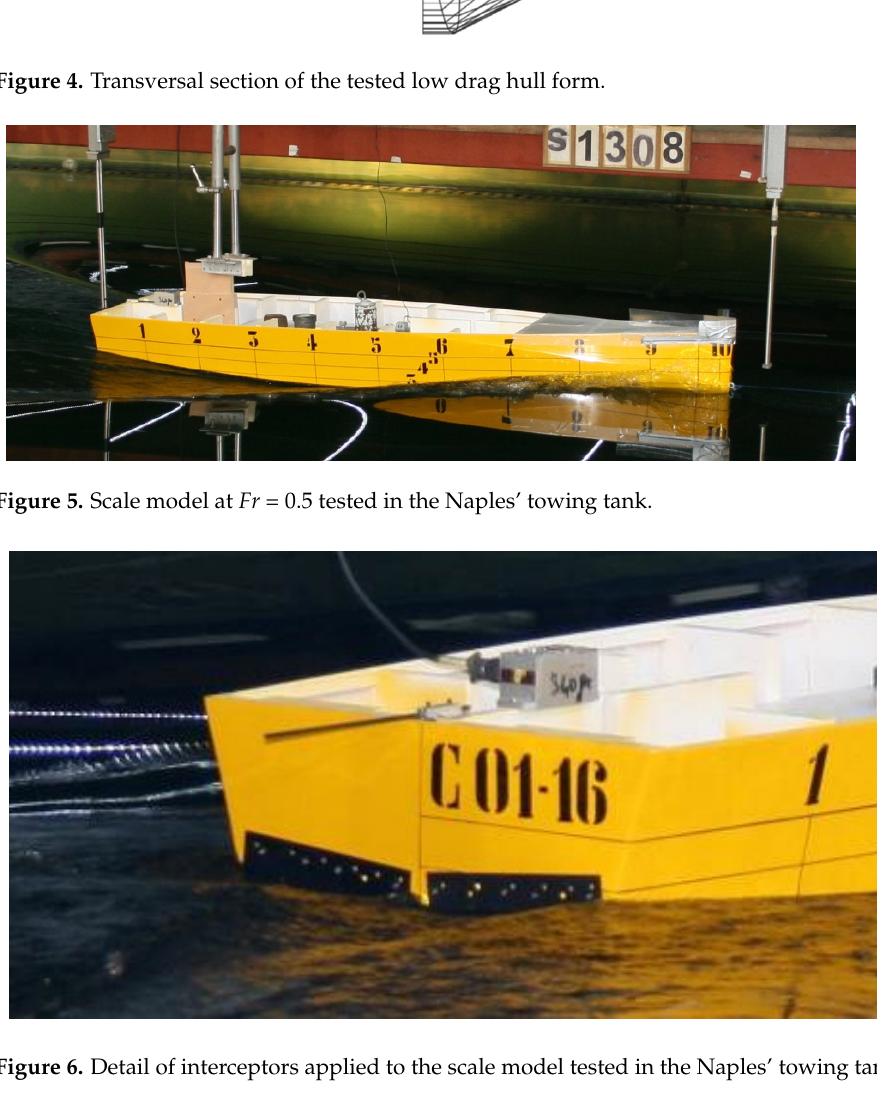
Figure 4. Transversal section of the tested low drag hull form.